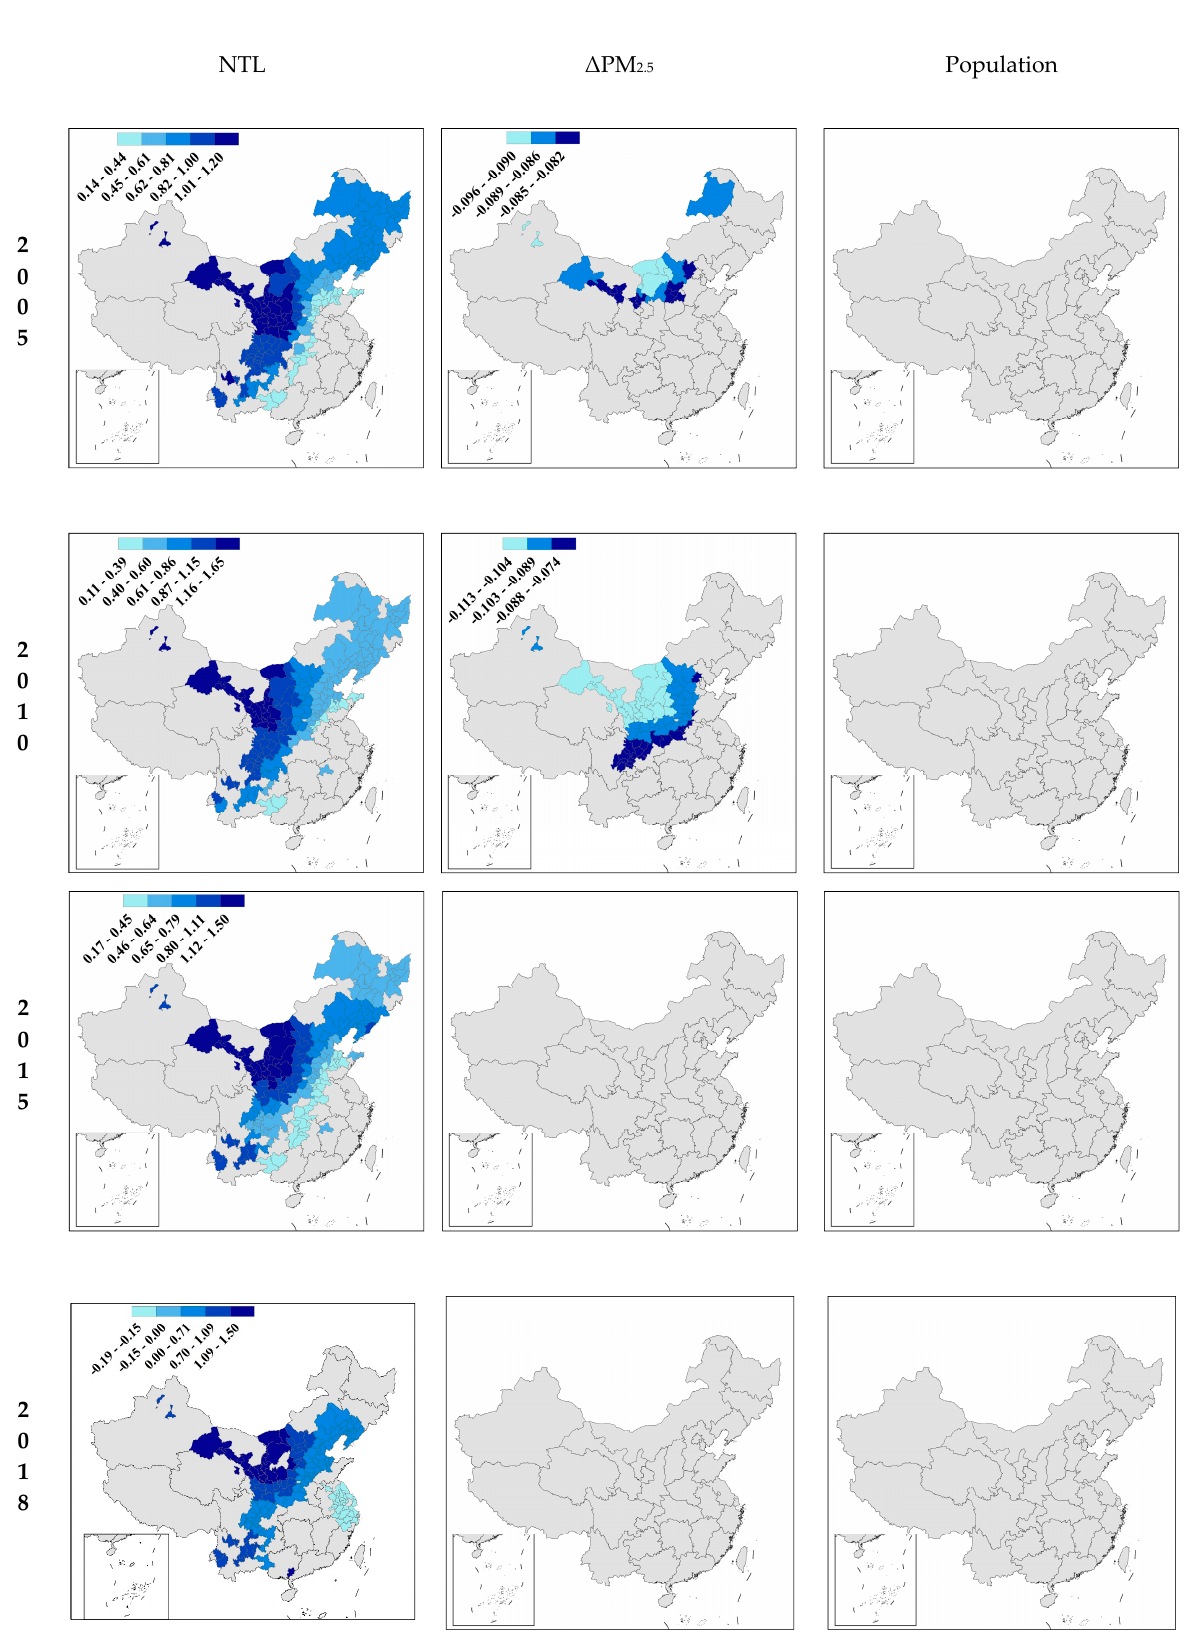
Figure 8. Spatial distributions of the coefficients of NTL, ∆ PM 2.5 , and Population for the nighttime MGWR model in 2005, 2010, 2015, and 2018.